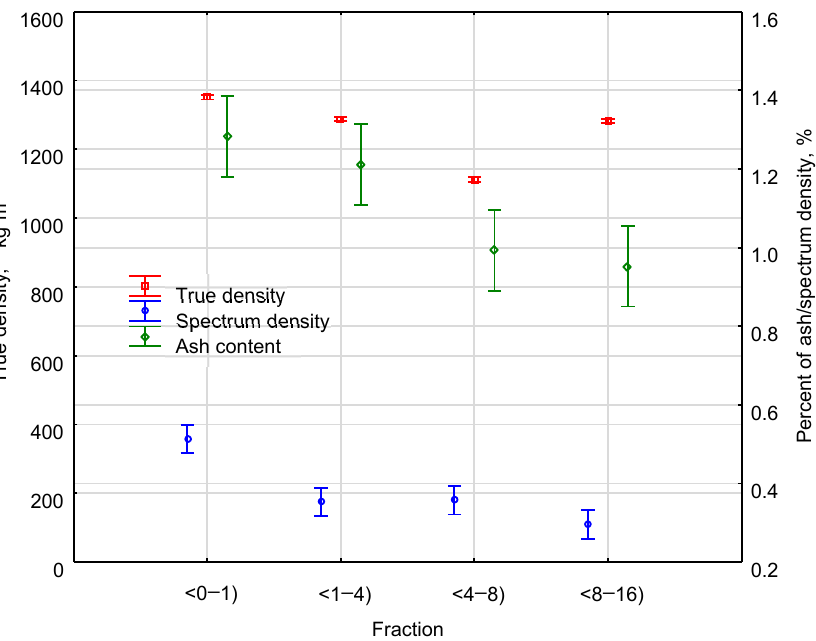
Figure 5. The expected marginal means for the briquettes are made from various fractions.